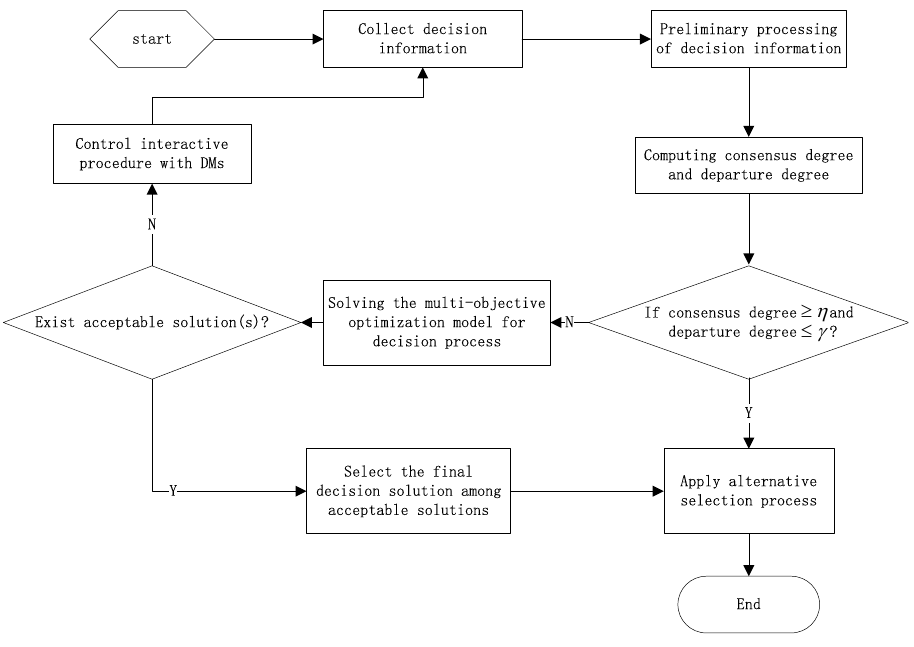
Figure 1: Framework of the proposed decision support model for